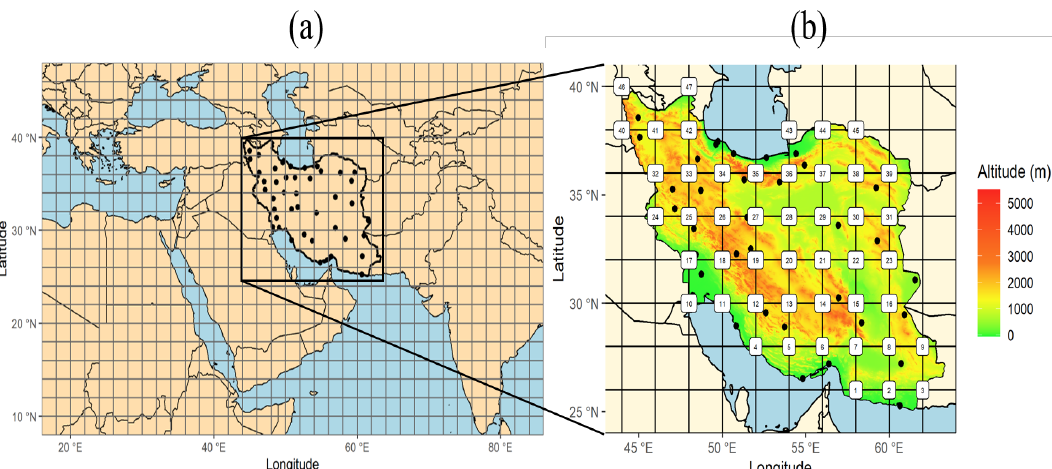
Figure 1. ( a ) Map of the Middle East showing 42 observations sites inside Iran and 598 grid points over the whole area. The Barnes interpolation method was used to re-grid and to build a rainfall field over 2 ◦ × 2 ◦ grids in Middle East. ( b ) Map of the Iran from 44 ◦ to 62 ◦ longitude and 26 ◦ to 40 ◦ latitude, including the sea and land, with 47 grid points of 2 ◦ × 2 ◦ for this study. This map was drawn by using a R package ‘ggplot2’